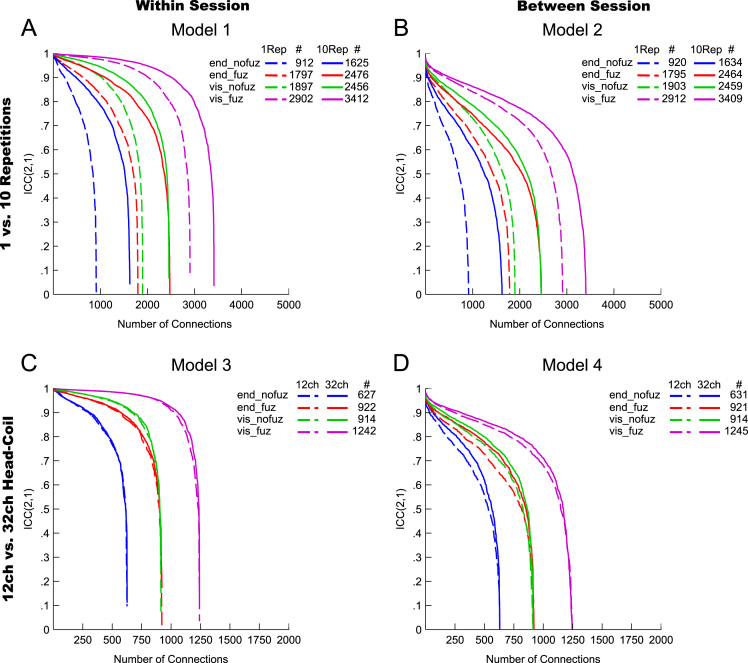
ICC(2,1) values for (A) Model 1, within-session reproducibility of reconstruction repetitions × streamline selection variant; (B) Model 2, between-session reproducibility of reconstruction repetitions × streamline selection variant; (C) Model 3, within-session reproducibility of type of head-coil × streamline selection variant; and (D) Model 4, between-session reproducibility of type of head-coil ×streamline selection variant. The y-axis denotes the magnitude of ICC values; the x-axis denotes the connections in descending order of ICC value magnitude. Dashed lines, 1 reconstruction repetition (A, B) and 12ch head-coil (C, D); solid lines, 10 reconstruction repetitions (A, B) and 32ch head-coil (C, D). Blue lines, endpoint_nofuzzy (end_nofuz); red lines, endpoint_fuzzy (end_fuz); green lines, visiting_nofuzzy (vis_nofuz); and purple lines, visiting_fuzzy (vis_fuz) streamline selection variant. #, total number of connections reconstructed in at least 95% of subjects for the given combination of streamline selection variant and reconstruction repetition (A, B) or for the given streamline selection variant across both 12ch and 32ch data (C, D). Note that the total number of connections was identical for 12ch and 32ch data because only connections found in both types of head-coil data were considered for analysis. For visualization purposes, negative ICC(2,1) values were set to zero (0.13% of values).